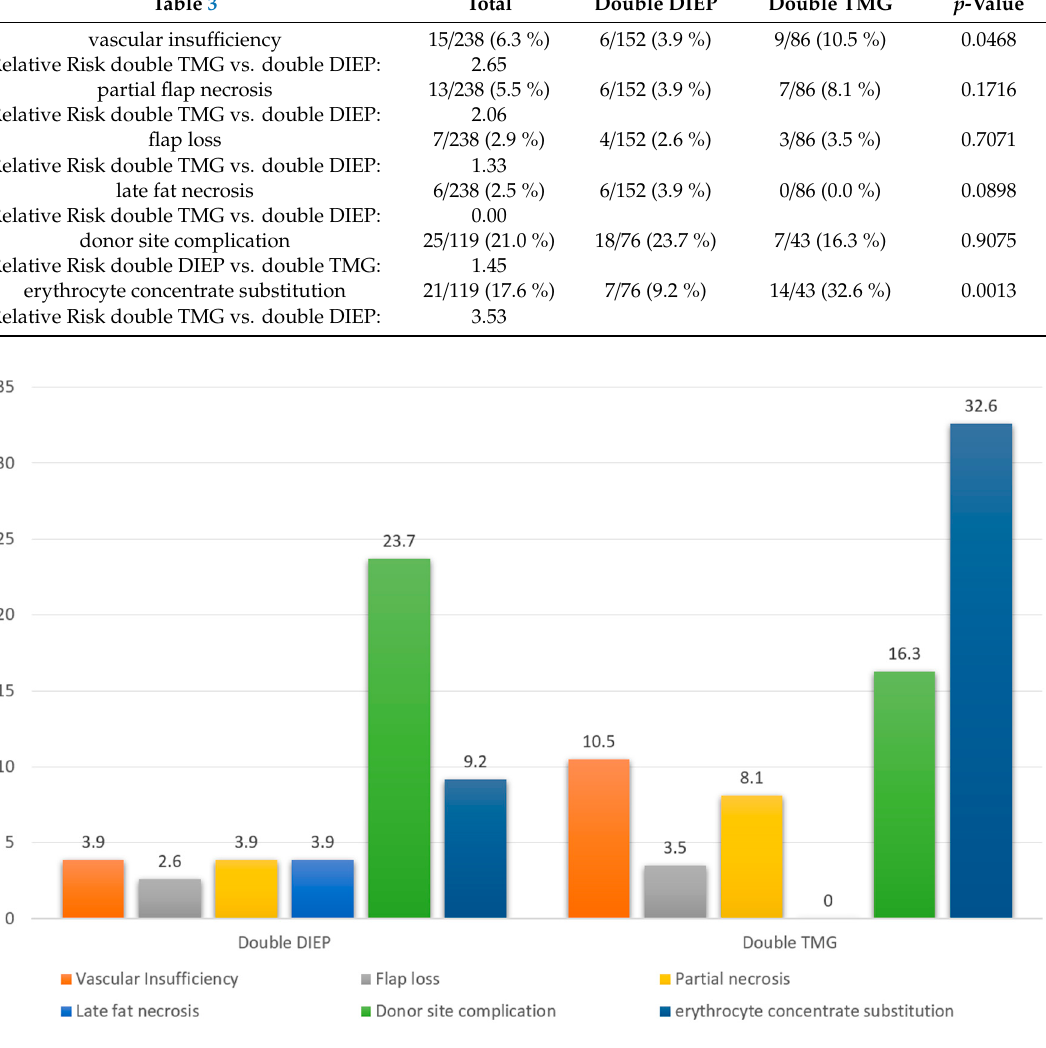
Table 4. Donor site morbidity in detail.